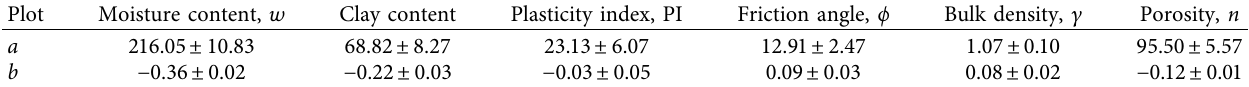
Table 4: Equation model y � ax b for interation between resistivity with soil parameters values. Plot Moisture content,